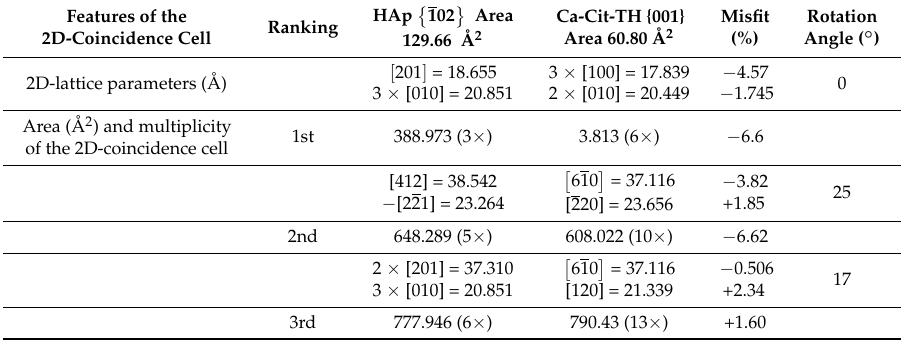
Table 2. 2D-coincidence lattices between the {100} and Ca-Cit-TH. Owing to the practical equality between the {100} and (cid:8) (cid:9) coincidences of the 102 form have been illustrated. Rotation angle refers to the angle formed between the vectors [100] of both the involved 2D cells.